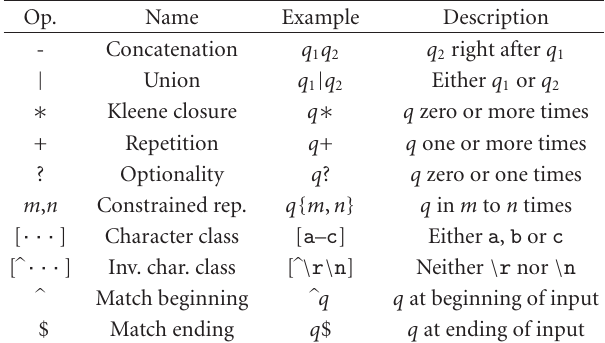
Figure 4: Graphical representation of the modified McNaughton- Yamada (MMY) construction. Note that unlike the original con- struction, no (cid:2) -transition-only node is introduced in rules (c) and (d), where the dashed ellipses are not part of the current construction. Table 1: REM operators support by our